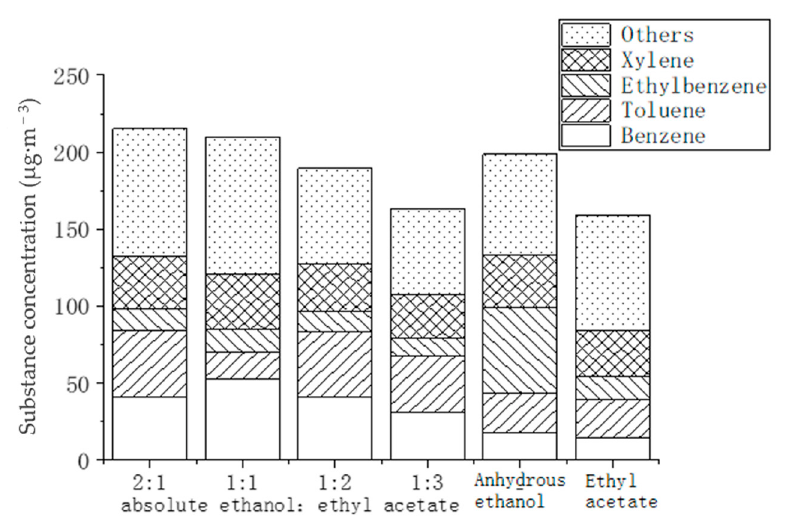
Figure 3. Effect of diluent ratios on benzenes emission.